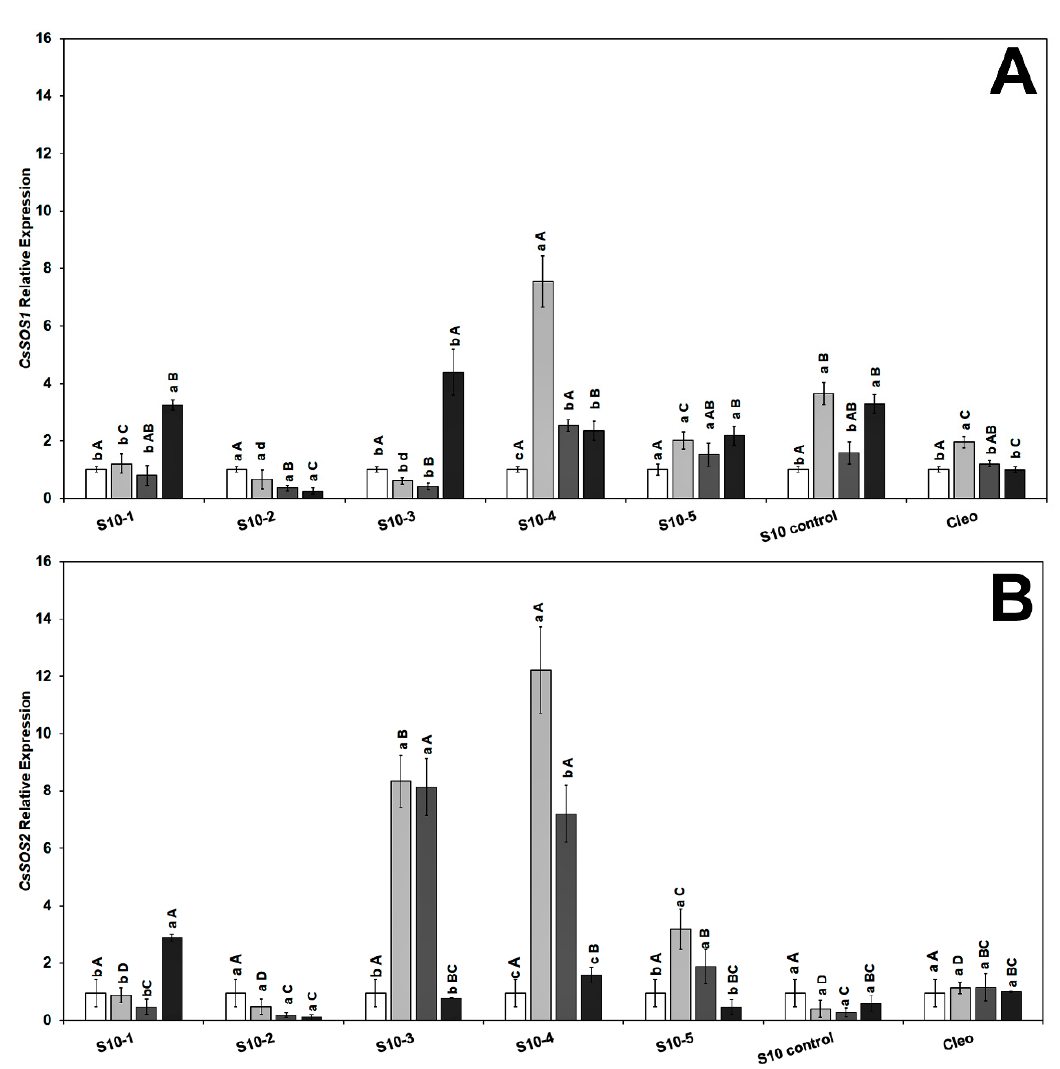
Figure 4. Effect of NaCl treatment and Ca Las infection on ‘Valencia’ sweet orange scions grafted onto S10-derived rootstocks and Cleopatra mandarin (control). ( A ) CsSOS1 and ( B ) CsSOS2 . Data represent means ± standard error. Mean separation between rootstocks at a particular treatment is indicated by differing uppercase letters; mean separation between treatments in a particular root- stock is indicated by differing lowercase letters by Tukey’s honestly significant difference test ( p ≤ 0.05).